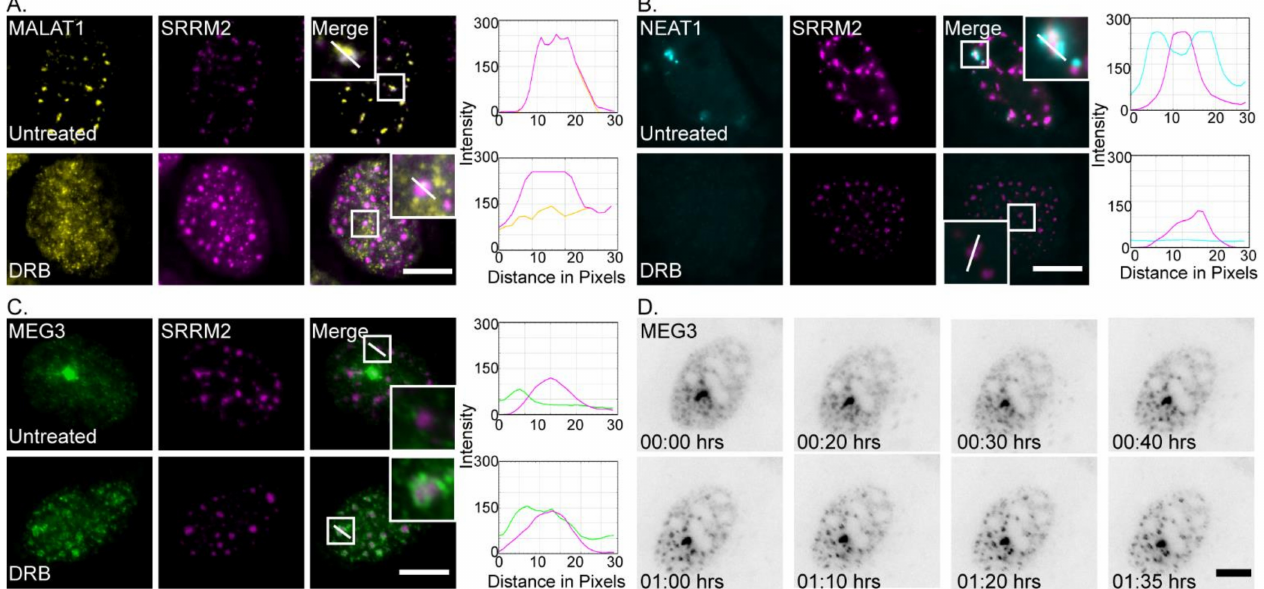
Figure 2. MALAT1 and NEAT1 lose nuclear speckle association in response to transcription inhibition while MEG3 is recruited to the nuclear speckle periphery. ( A ) (Top) RNA FISH to endogenous MALAT1 lncRNA (yellow) overlapped with antibody staining for nuclear speckles marked with SRRM2 (magenta) in untreated cells. (Bottom) When treated with the transcription inhibitor DRB (2 h), MALAT1 lncRNA dispersed in the nucleoplasm and the overlap with SRRM2 was lost. Enlargements of designated areas are in the boxed regions. Right—intensity line analysis from the boxed region along the white line. ( B ) (Top) RNA FISH to endogenous NEAT1 (cyan) overlapped with the periphery of nuclear speckles marked with an SRRM2 (magenta) in untreated cells. (Bottom) In DRB-treated cells, NEAT1 dispersed in the nucleus. Right—intensity line analysis from the boxed region along the white line. ( C ) (Top) MEG3-MS2 tagged with YFP-MS2-CP (green) partially associated with nuclear speckles marked with an antibody to SRRM2 (magenta) in untreated cells. (Bottom) When treated with DRB, MEG3 localized to the nuclear speckles and there was increased association with the SRRM2 signal. Bars = 10 µ m. Right—intensity line analysis from the boxed region along the white line. ( D ) Frames from a live-cell movie (Movie S2) of a dox-induced MEG3-MS2 cell expressing the transcript coated with YFP-MS2-CP, starting 15 min after DRB treatment. Images were captured every 5 min for the duration of 1.5 h. The grey image is an inverted version of the transcript tagged with YFP-MS2-CP (black). Bar = 5 µ